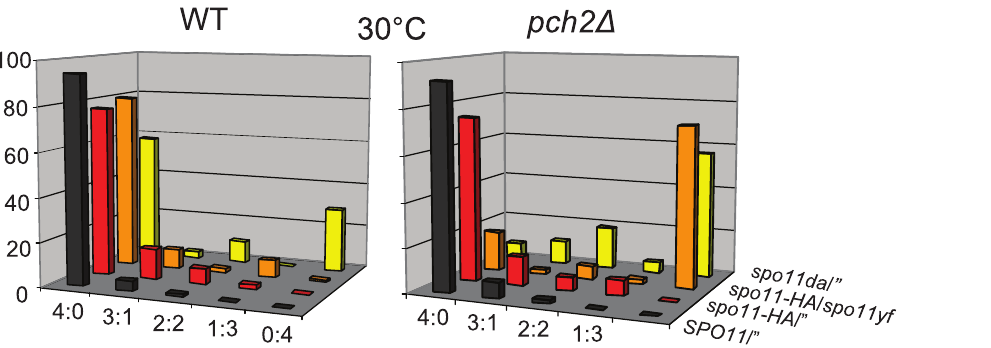
Figure 7. Spore viability patterns at reduced DSB levels in WT and pch2 D at 30 u C. Tetrads were dissected from strains with the indicated genotypes of spo11 alleles. Ratios 4:0, 3:1, 2:2, etc. indicate the frequencies of four-spore viable, three-spore viable, two-spore viable, etc. tetrads. spo11 hypomorphic mutants form , 80% ( spo11-HA/’’ ), , 30% ( spo11-HA/spo11yf ), and , 20% ( spo11da/’’ ) of WT DSB levels [29].